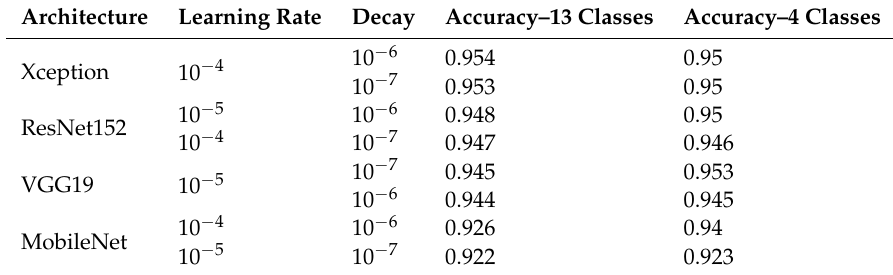
Table 2. Results of Chart Classification. Highlight to Xception network with best accuracy results. Blue cells indicate the right predictions and orange ones indicate high error